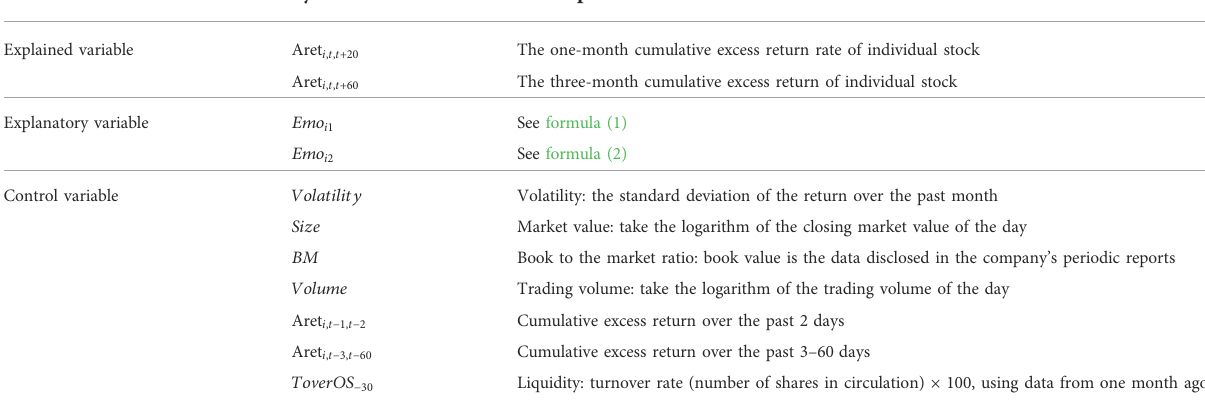
TABLE 1 Description 1 of variable de fi nition 1 . Variable